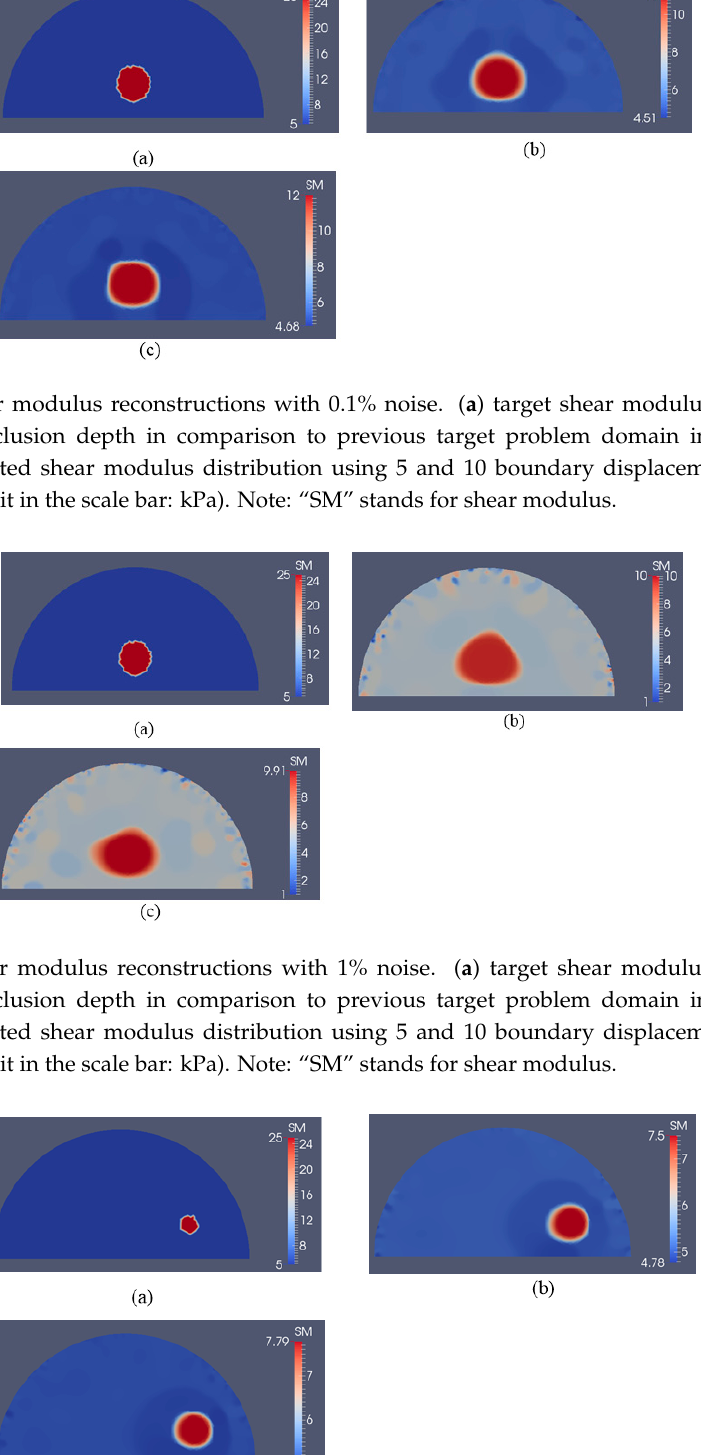
Figure 11. Shear modulus reconstruction with 1% noise. ( a ) target shear modulus distribution with a smaller inclusion radius of 0.5 cm is defined to study detectability of the inclusion to its size; ( b , c ) reconstructed shear modulus distribution using 5 and 10 boundary displacement data sets, respectively (unit in the scale bar: kPa). Note: “SM” stands for shear modulus. To test shape detectability of this approach, we define the target problem domain given in Figure 12a with an elliptic shaped inclusion. We apply the same boundary conditions as in Figure 4a,b and add 0.1% noise to boundary displacements. The reconstructed shear modulus distributions are shown in Figure 12b,c for 5 and 10 boundary displacement data sets, respectively, for a regularization factor of 5 × 10 − 11 . We observe that the reconstructed inclusion shape follows the trend of an ellipse. In Figure 13, the noise level is increased to 1% and the regularization factor is chosen to be 5 × 10 − 10 and the shape deteriorates as anticipated, but an elliptic shape-like trend appears to be present.